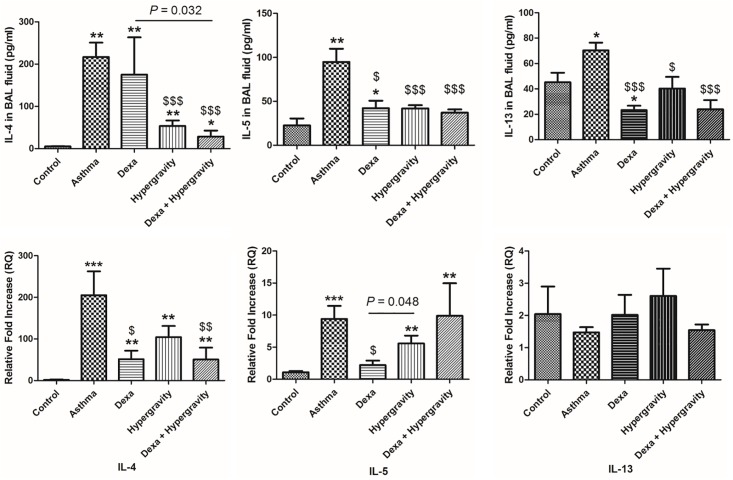
Levels of IL-4, IL-5, and IL-13 in the broncho-alveolar lavage fluid (upper column) and expression of IL-4, IL-5, and IL-13 gene in the lung homogenate, analyzed using PCR (lower column).* Significant difference from the control group, p < 0.05; ** significant difference from the control group, p < 0.01; *** significant difference from the control group, p < 0.001; $ significant difference from the asthma group, p < 0.05; $ $ significant difference from the asthma group, p < 0.01; $ $ $ significant difference from the asthma group, p < 0.001 (the Kruskal-Wallis and Mann-Whitney U tests).